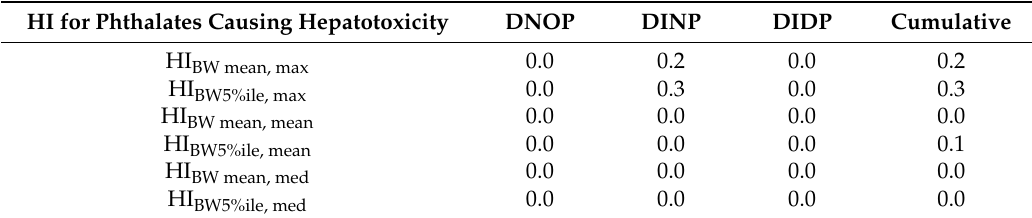
Table 7. HI for hepatotoxicity from cumulative exposure to DINP, DIDP and DNOP via ingestion and dermal routes for maximum, mean and median